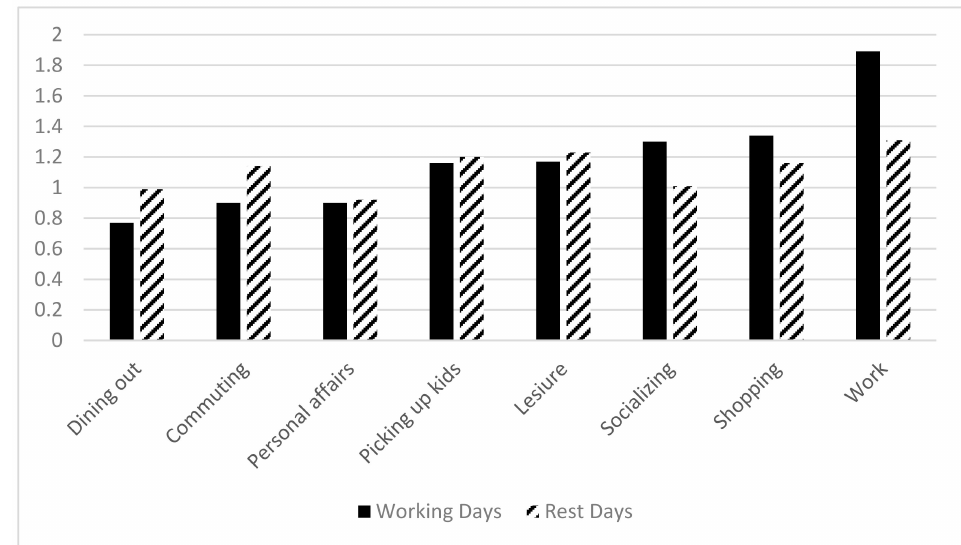
Figure 2. Coefficient of variation of different